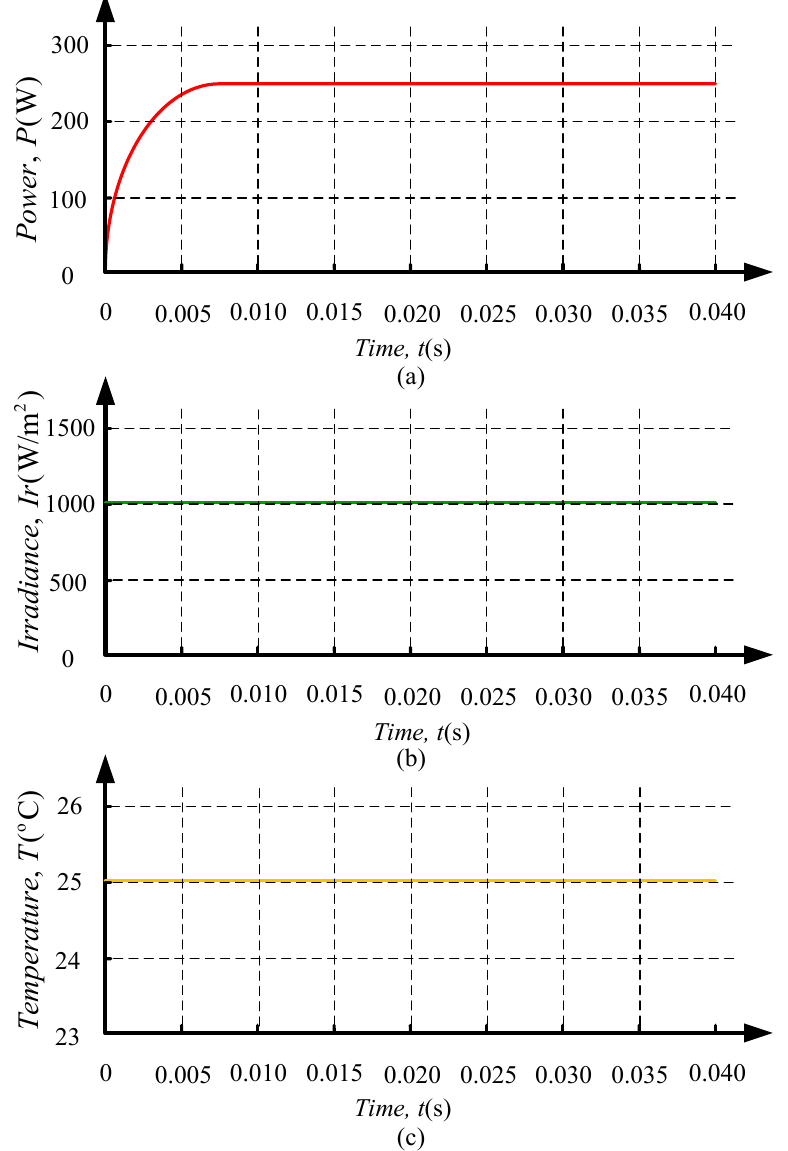
Figure 11. Output: ( a ) Power verses time at; ( b ) constant irradiance; ( c ) constant temperature. In the second case, the system is simulated for various irradiance levels as follows: 800 W / m 2 for 0.015 s, 600 W / m 2 for 0.03 s, and 1000 W / m 2 for the rest of the time. In this scenario, it again tracks the maximum power point within the same designed spam of time (0.005 s) and gives the power of 200 W, 150 W, and 250 W, respectively, as shown in Figure 12. This power is tracked through the fuzzy logic controller, where fuzzy rules are employed as given in Table 1.